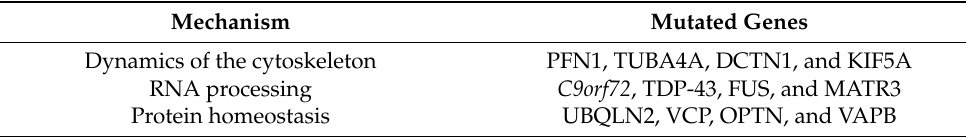
Table 3. Altered pathways in